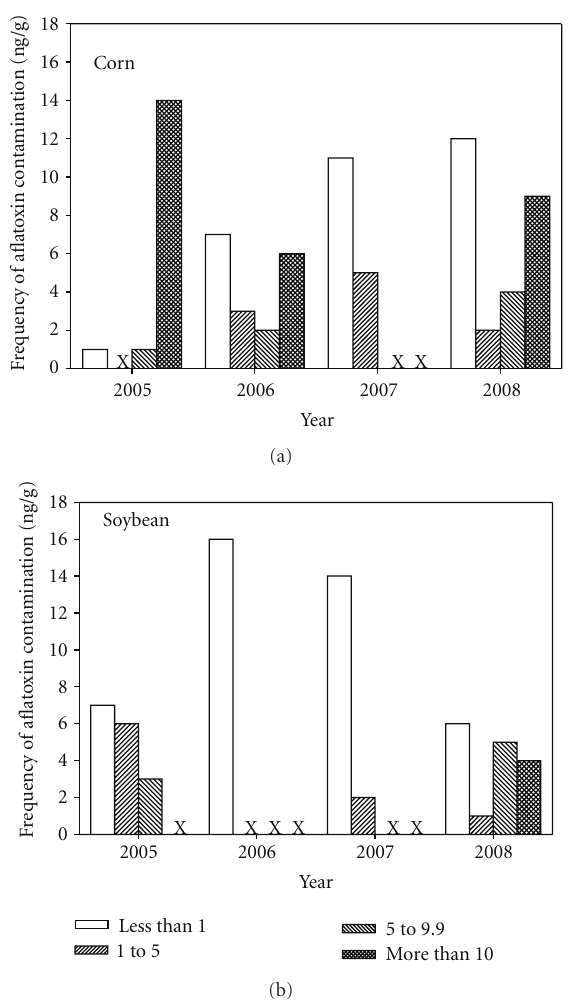
Figure 2: Frequency of fumonisin contamination levels in corn (a) and soybean (b) in four years of field trials, each year 16 plots were planted to corn and soybean. X in the graph indicates zero